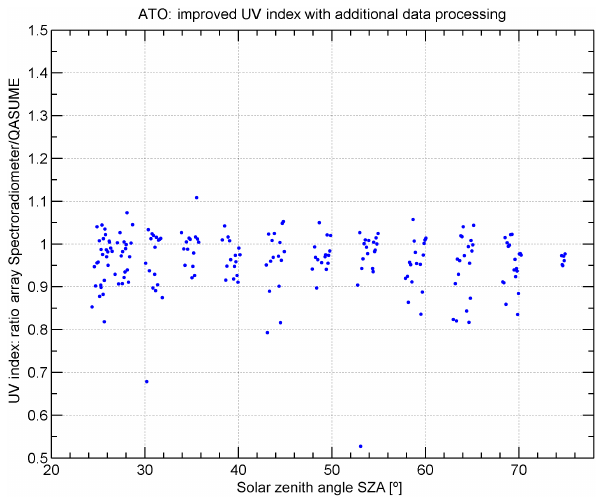
Figure 6. The ratio of UV indices derived from the ATO array spec- troradiometer to the QASUME reference spectroradiometer, as a function of solar zenith angle. The UV indices were recalculated after additional post-processing of the original data, to correct for unrealistic values at short wavelength in the UV-B part of the spec-